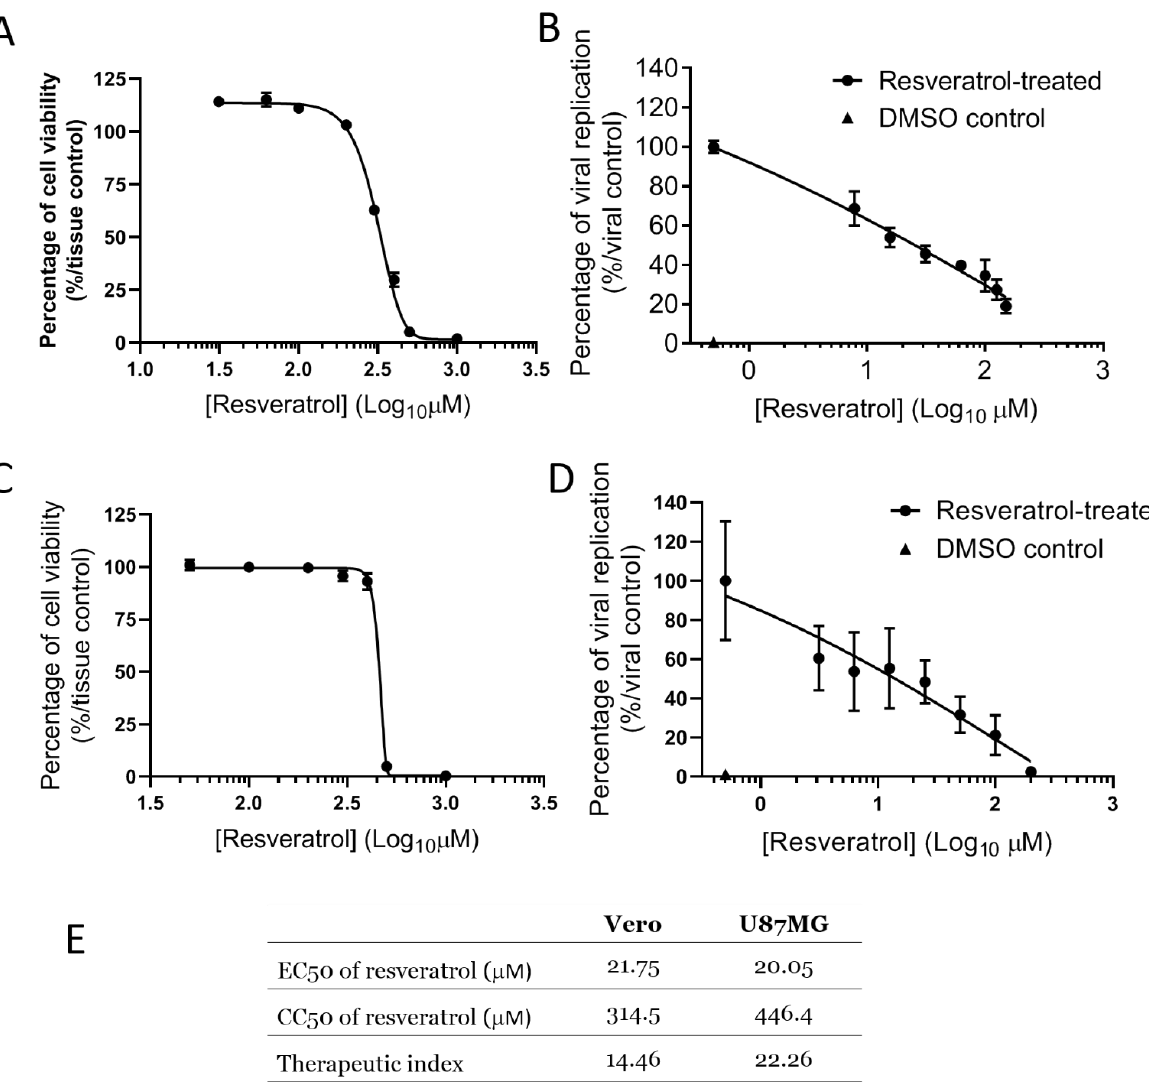
Figure 1. 50% cytotoxic dose and effective dose (CC50 and EC50) of resveratrol against Venezuelan equine encephalitis virus (VEEV) in two distinct cell types. Vero ( A , B ) and U87MG ( C , D ) cells were treated with resveratrol at indicated concentrations (CC50) along with VEEV-TC-83 infection for 16 h at an MOI of 0.1 followed by measurement (EC50) of ( A , D ) cell viability and ( B , E ) replication of reporter VEEV-TC83luc quantified by cellular ATP and luciferase activity, respectively. The figures were plotted following the normalizing toward viral control groups. Viral control refers to no resveratrol-treated but VEEV-infected cells, while mock control was defined as cells treated with a solvent and without infection. ( E ) The CC50, EC50, and therapeutic index (TI) were estimated via non-linear regression with GraphPad Prism v7.0 to determine the 50% cell viability and effective dose. Data were presented as means ± SEM.